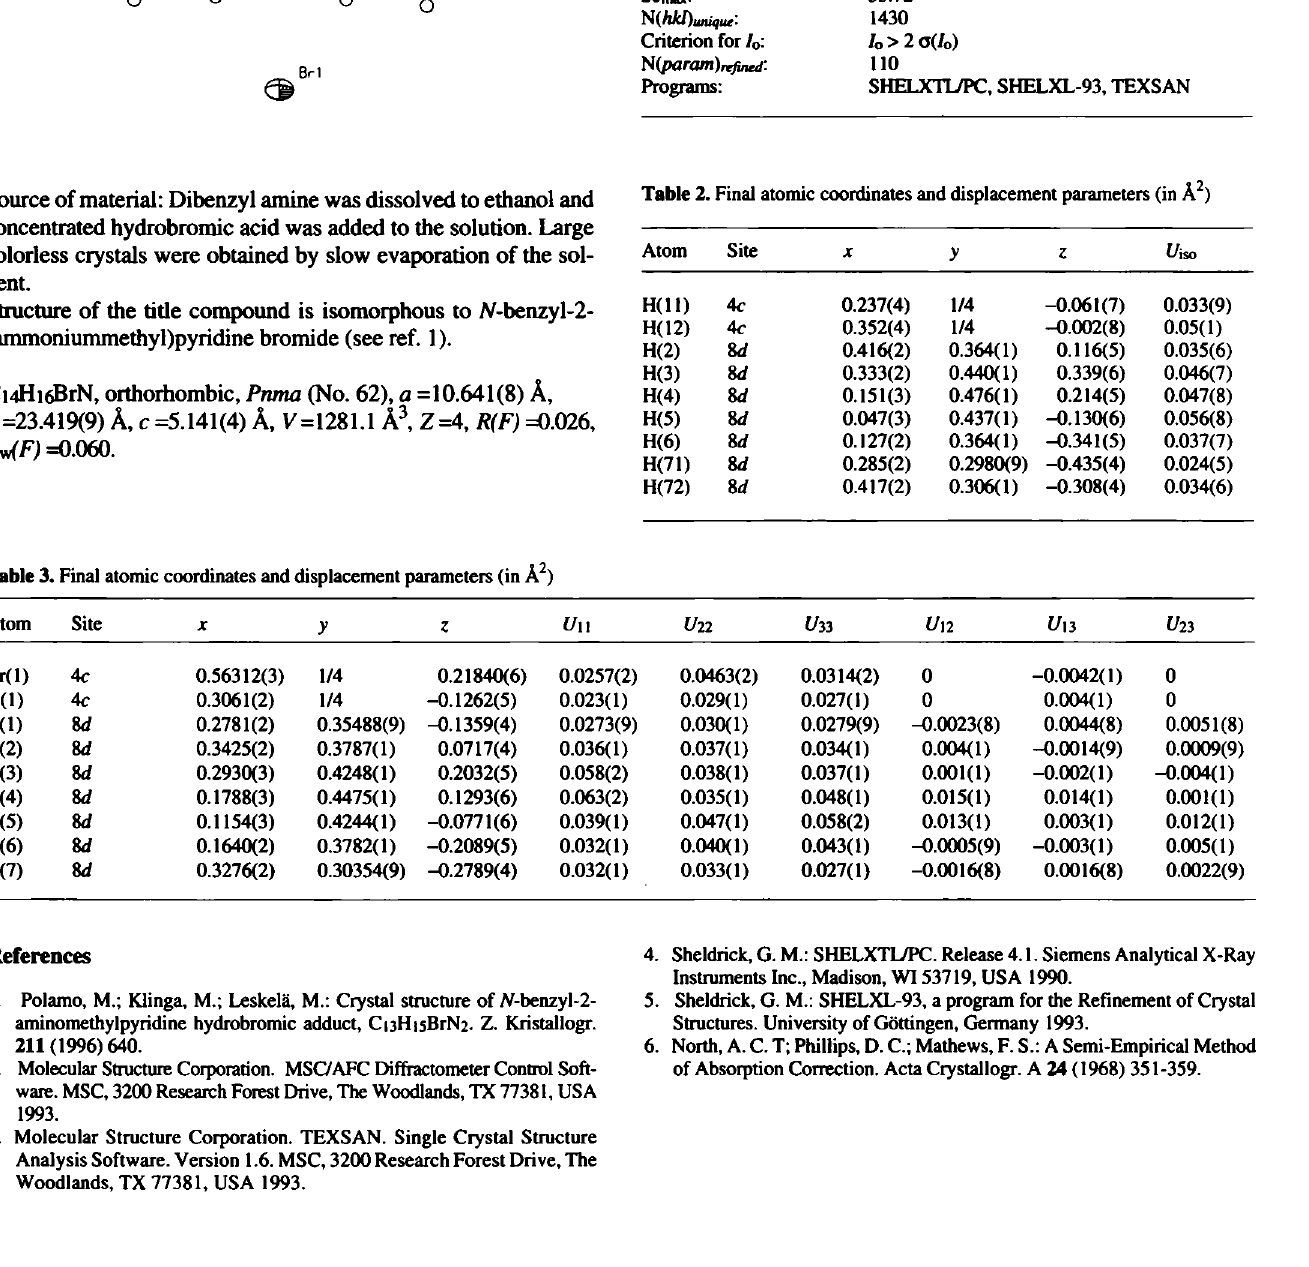
Table 1. Parameters used for the X-ray data collection Crystal: